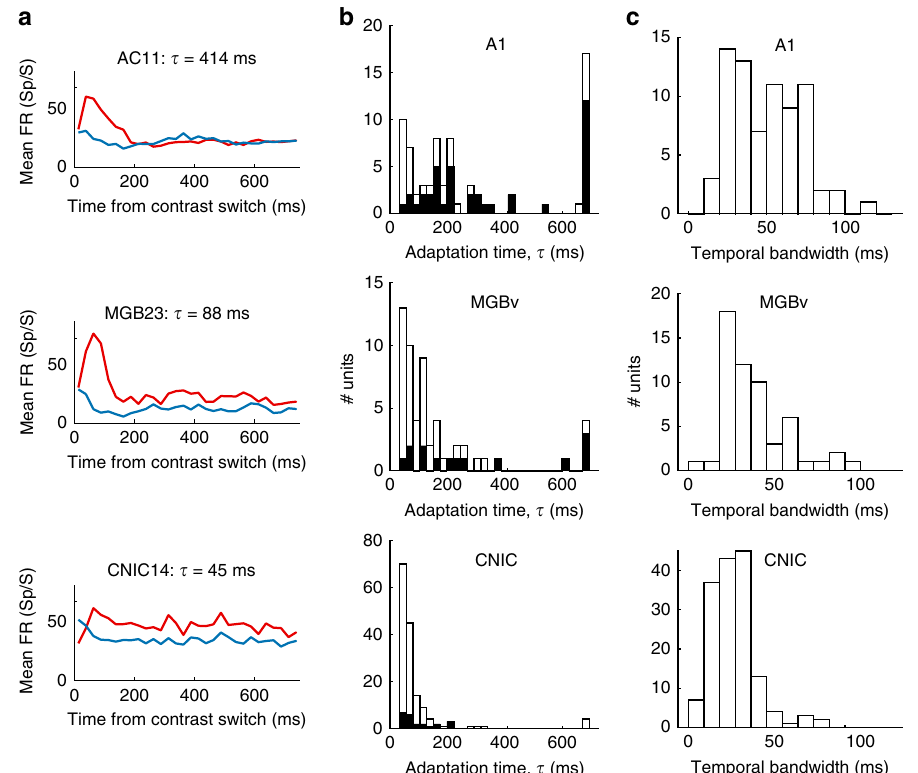
Fig. 6 Increasing time constants of contrast adaptation along the ascending auditory pathway. a Mean PSTHs from example units recorded in A1, MGBv, and CNIC after switching from low to high contrast (red) or high to low contrast (blue). The adaptation time constant for these units is given above each plot. b Contrast adaptation time constants ( τ ) for all units recorded using continuously switching contrasts in A1, MGBv, and CNIC. Black bars indicate a subset of these units whose model prediction performance ( cc pred ) was improved by including an adaptation time constant in the contrast-dependent LN model. c Temporal bandwidth of these units. Source data for b , c are provided as a Source Data fi